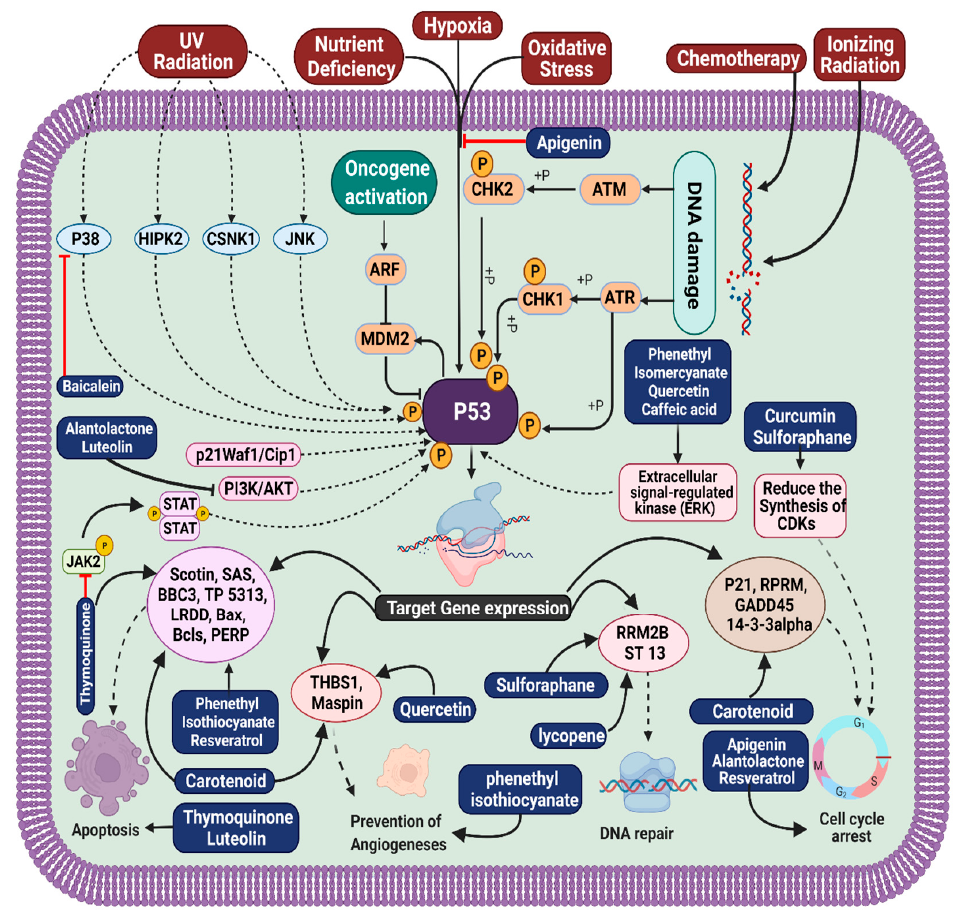
Figure 2. Illustration representing the probable blockade of sites by small molecules in the gastrointestinal tract and associated cancers.